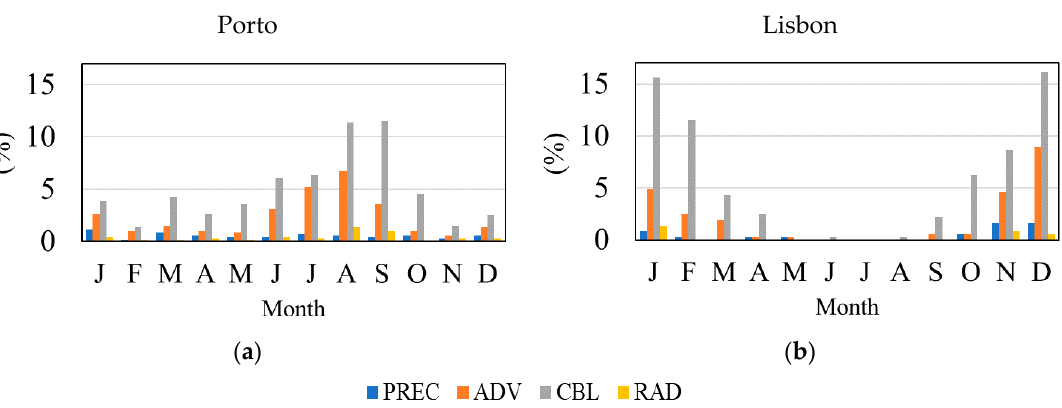
Figure 7. Monthly distribution of the event relative frequency according to the fog types at Porto ( a ) and Lisbon ( b ).